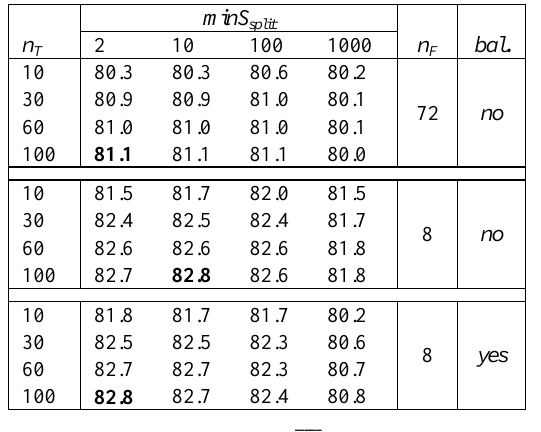
Average F1 score ( ) in [%] for different combinations of hyper-parameters of the RF 𝐹 1 ���� : Gradient; number of samples in a tree node for splitting; bal : balancing the training set or not. ∇